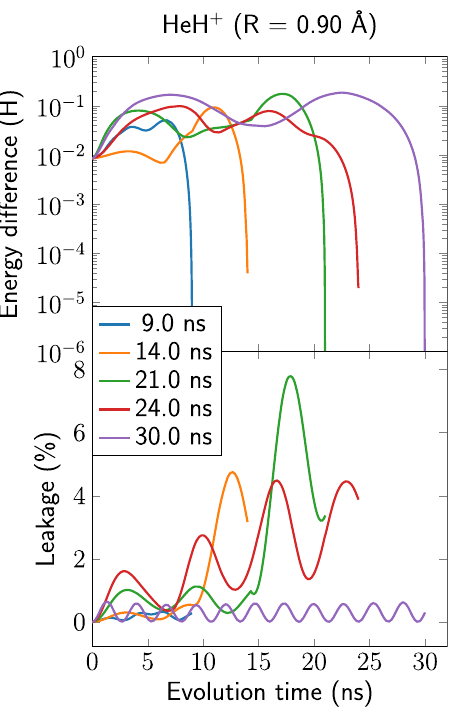
Fig. 5 Error in energy and leakage for HeH + . Energy difference shown between ctrl-VQE and FCI (top) and leakage (bottom) along the time evolution steps with optimal pulses of different durations for HeH + with a bond distance of 0.90 Å. Optimized pulse parameters are provided in the